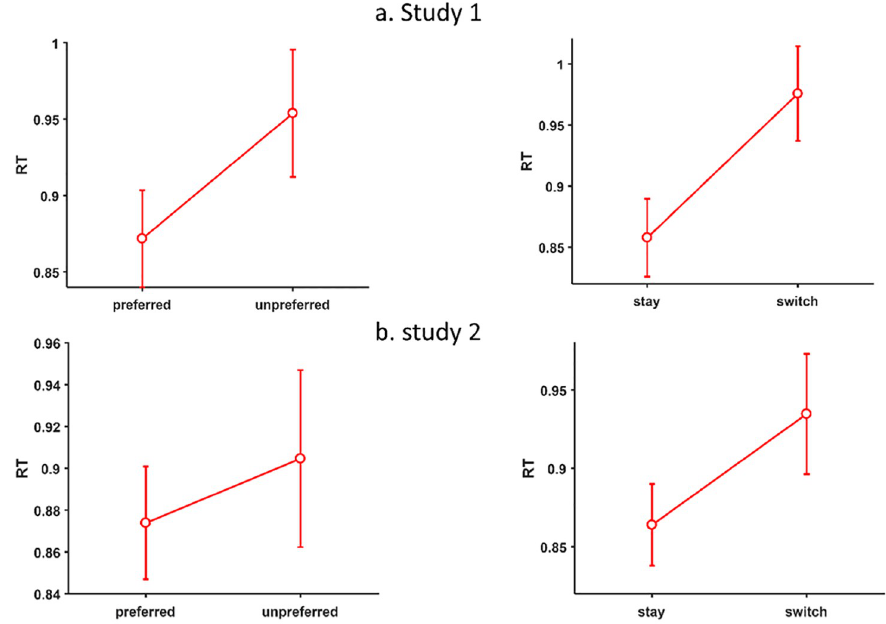
Fig 6. Results of studies 1 and 2 for RT (in seconds) for trials in which participants choose the preferred vs. the unpreferred option (left) and for trials in which participants stayed with the preferred option vs. switch from the unpreferred to the preferred option